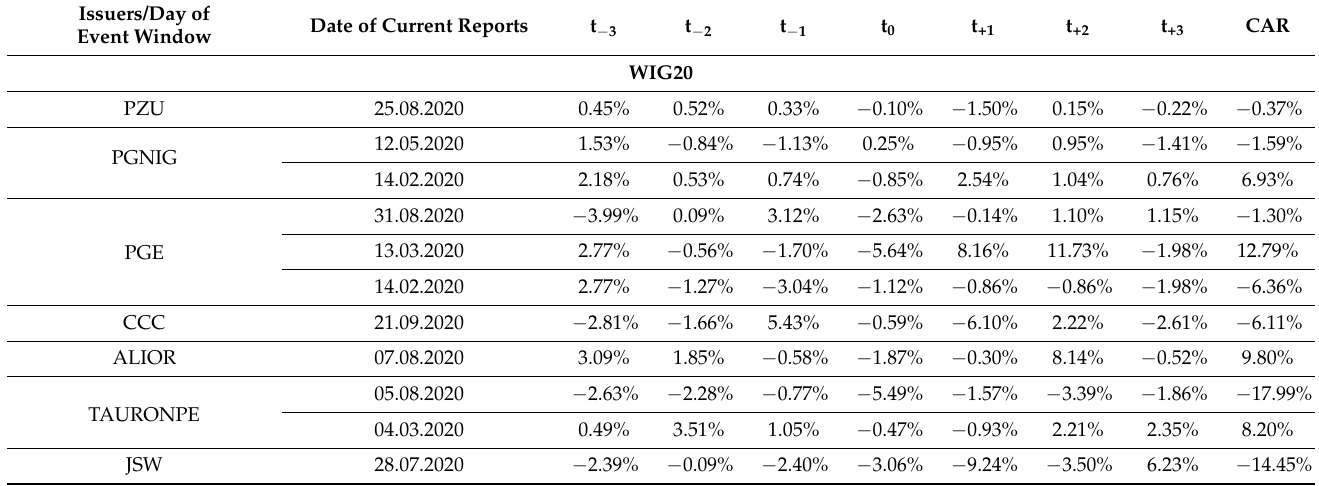
Table A2. Individual AR for each qualified case of reporting IoA by issuers from the WIG index in the year 2020 (in percentage